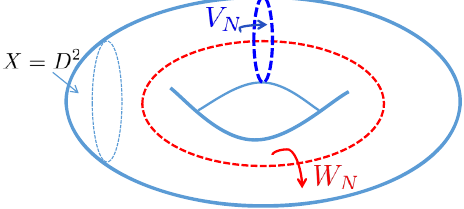
˜ X FIG. 2. Z × Z bundle on ¼ T 2 where the domain walls N N are inserted beyond ∂ X ¼ S 1 and a corresponding transformation is acted across a domain wall according to the domain-wall orientation indicated